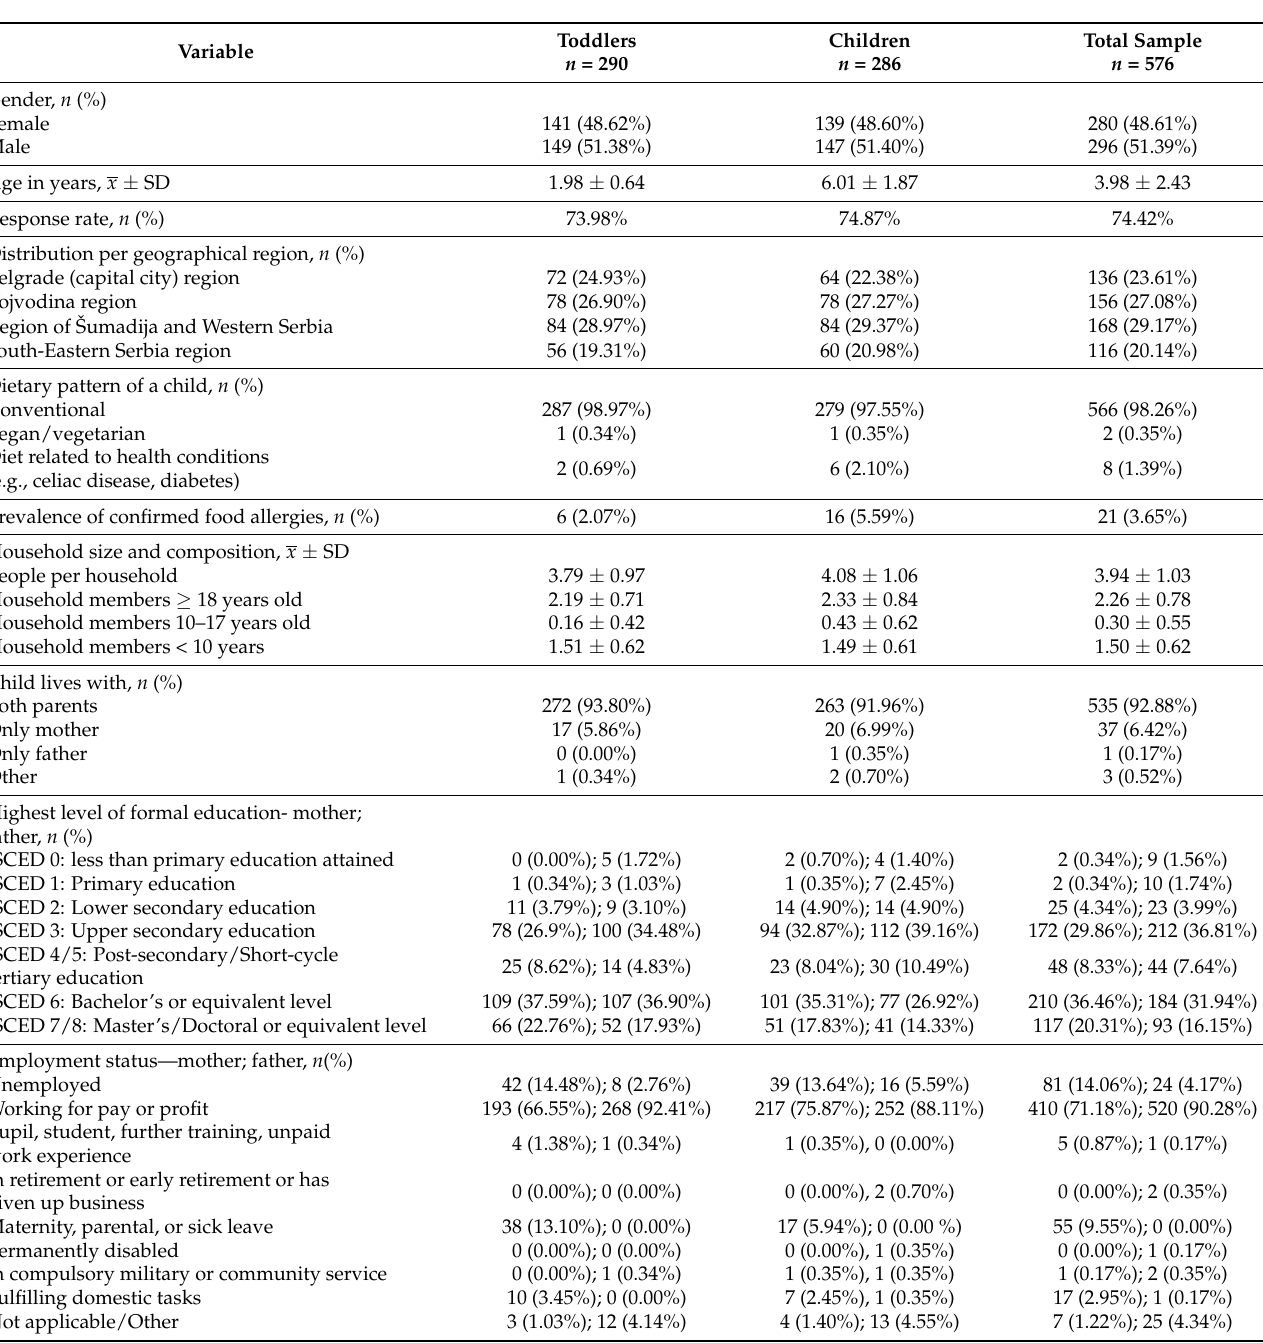
Table 2. Characteristics of the study